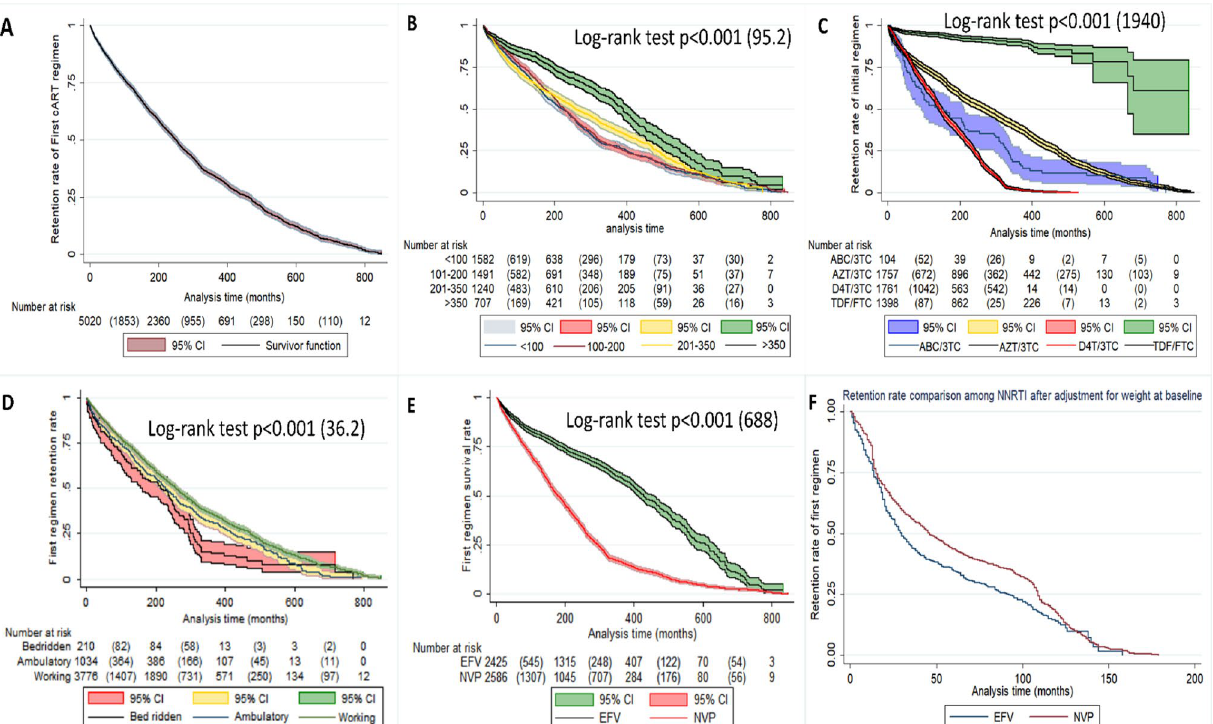
Figure 6. Unadjusted and adjusted Kaplan–Meier curves for: overall retention rate of first regimen across the follow-up months ( A ), unadjusted difference of retention rates among CD4 + T cell counts ( B ), unadjusted difference of retention among the initially used cART backbones ( C ), unadjusted difference across categories of initial functional status ( D ), unadjusted difference of first regimen retention between the NNRTIs used ( E ) and figure F represents adjusted difference of NNRTI for initial body